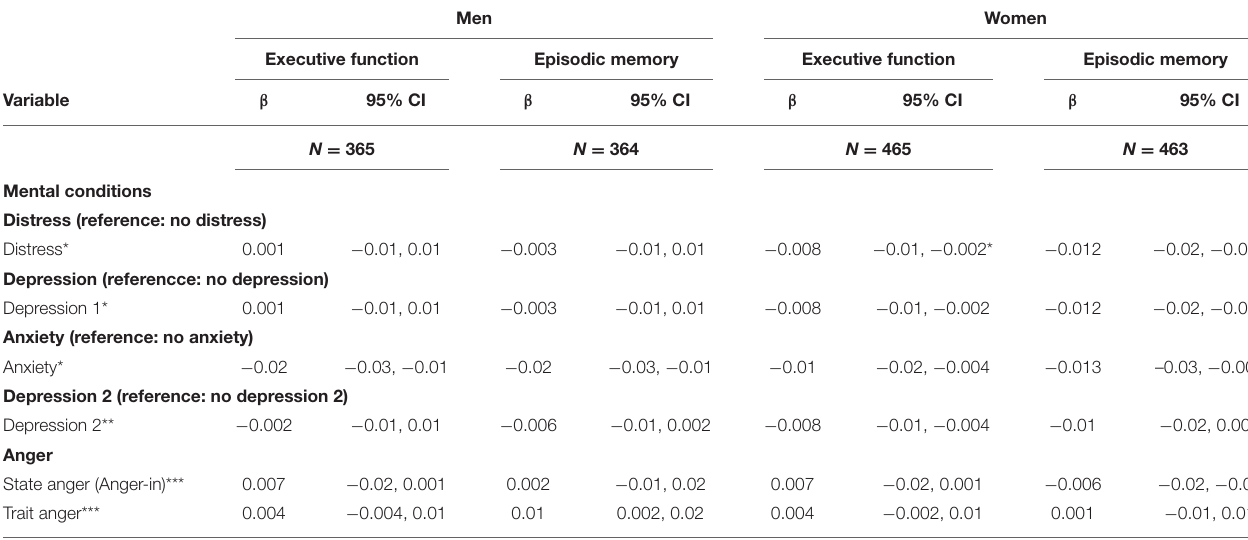
TABLE 4 | Effects of mental health (depressive-, anxiety-, or anger symptoms) on executive function and episodic memory 10 years after baseline on men and women, adjusted for baseline age, time, socio-demographic and—economic variables United States,